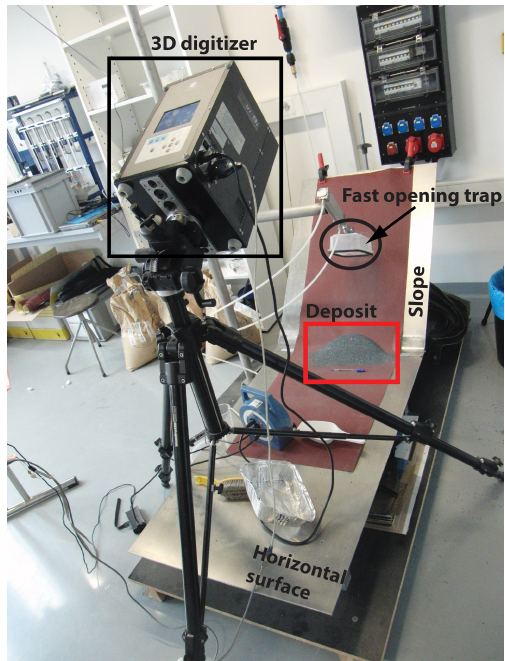
Figure 2. Laboratory setup.